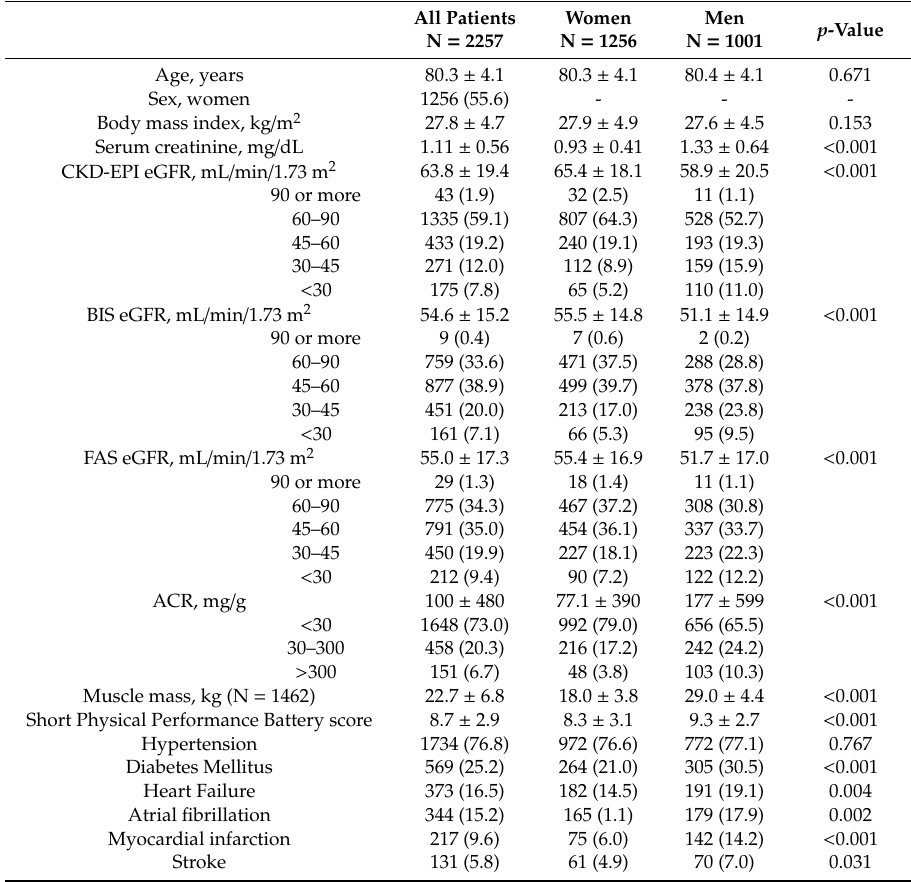
Table 2. General characteristics of the study population in the SCOPE